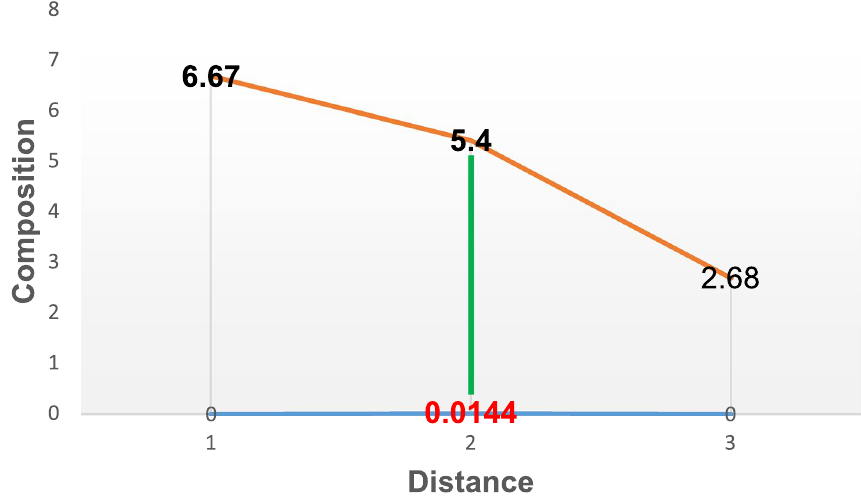
Figure 2. Diffusion of carbon atoms into the surface of grey cast iron at 900° for 60 min.